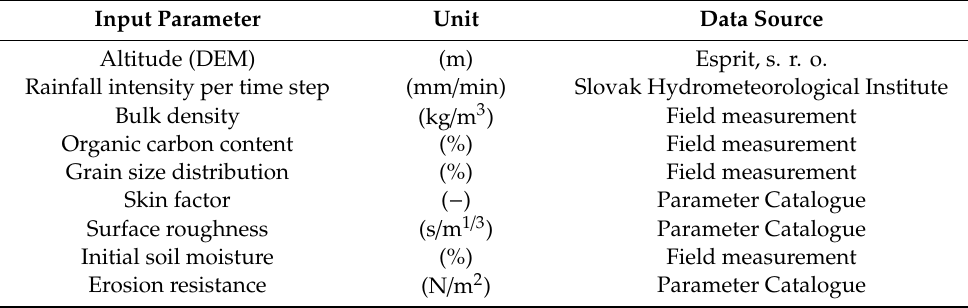
Table 2. The input soil parameters required by the EROSION-3D